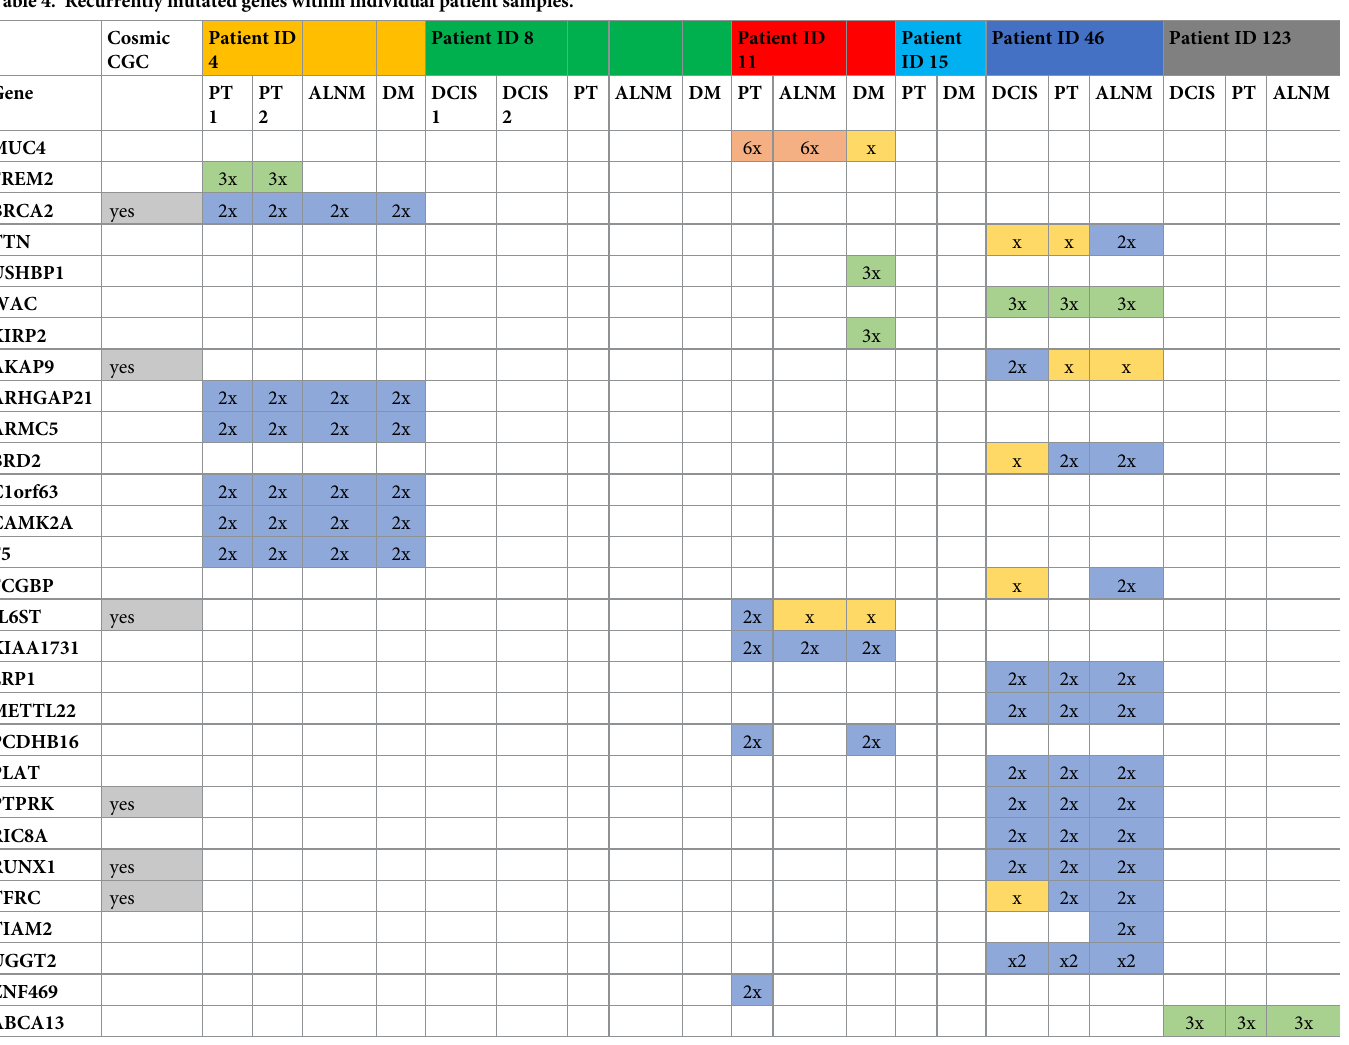
Table 4. Recurrently mutated genes within individual patient samples.